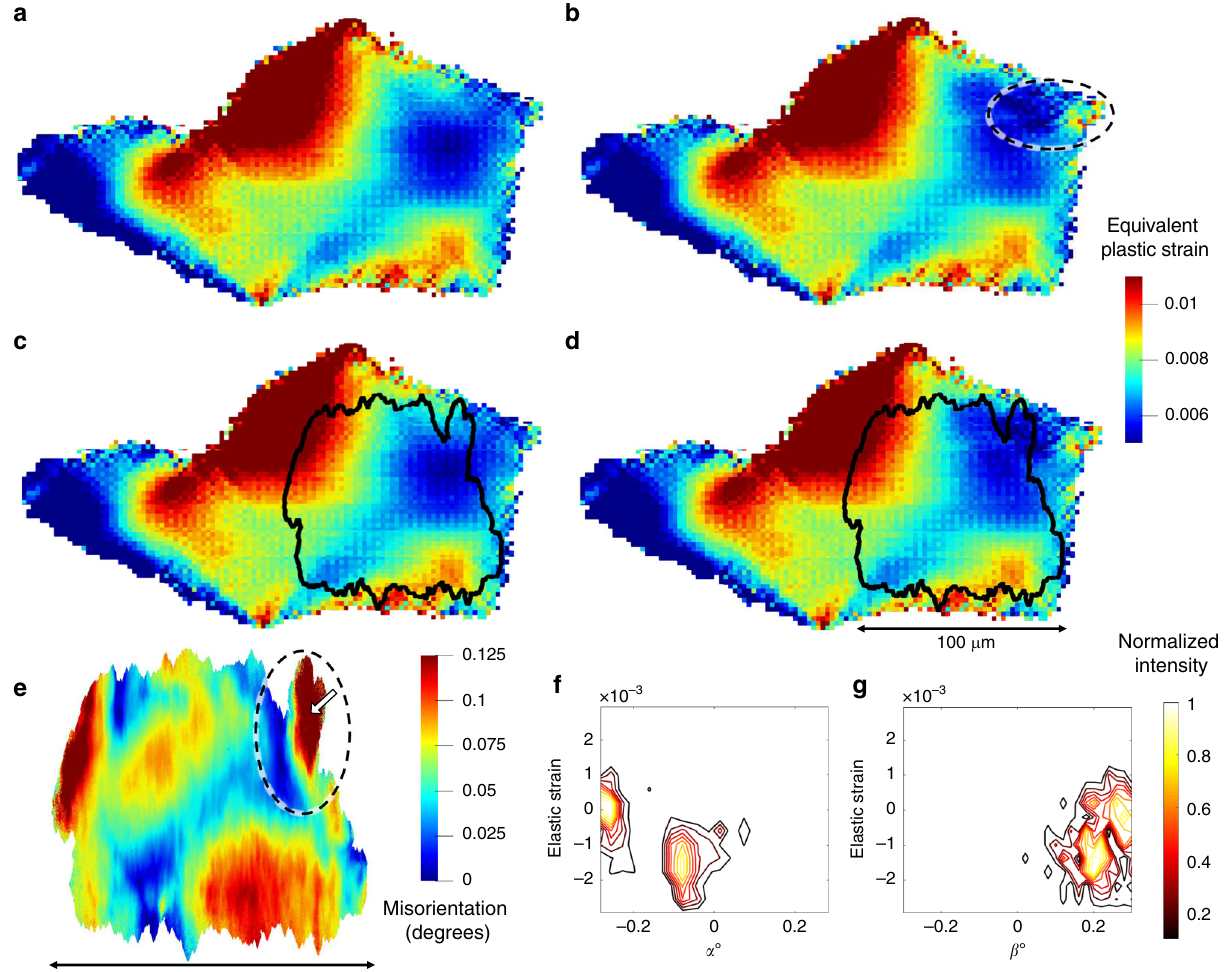
Fig. 6 DFXM and CP-FFT Comparison – Plastic Metrics. ( a ) CP-FFT model result of equivalent plastic strain without twin instantiation; ( b ) with twin instantiation. ( c ) CP-FFT model from a with DFXM outline from e . ( d ) CP-FFT model from b with DFXM outline from e . ( e ) Misorientation from DFXM combined mosaicity and elastic strain scan. ( f , g ) Contour plots displaying diffraction intensity data from a single voxel within the dipole region of the DFXM combined mosaicity and elastic strain scan labeled by black/white arrow in e of elastic strain vs α ( f ) and elastic strain vs β ( g